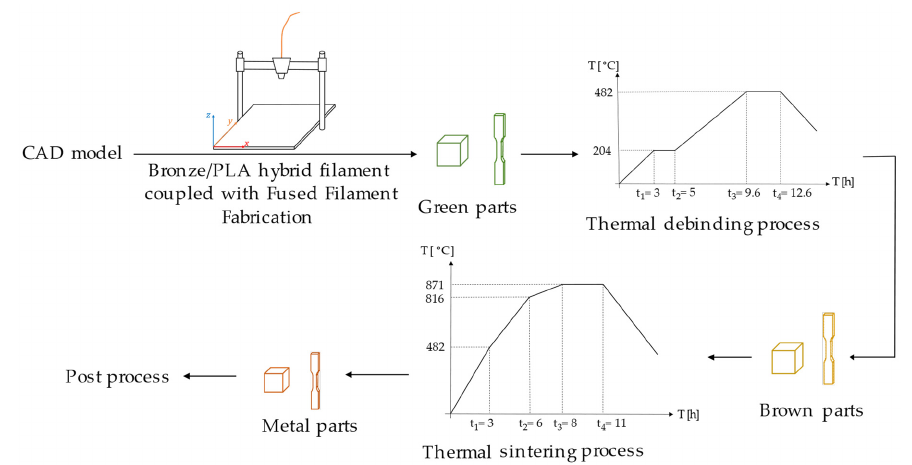
Figure 1. Scheme of bronze/PLA hybrid filament coupled with FFF process.